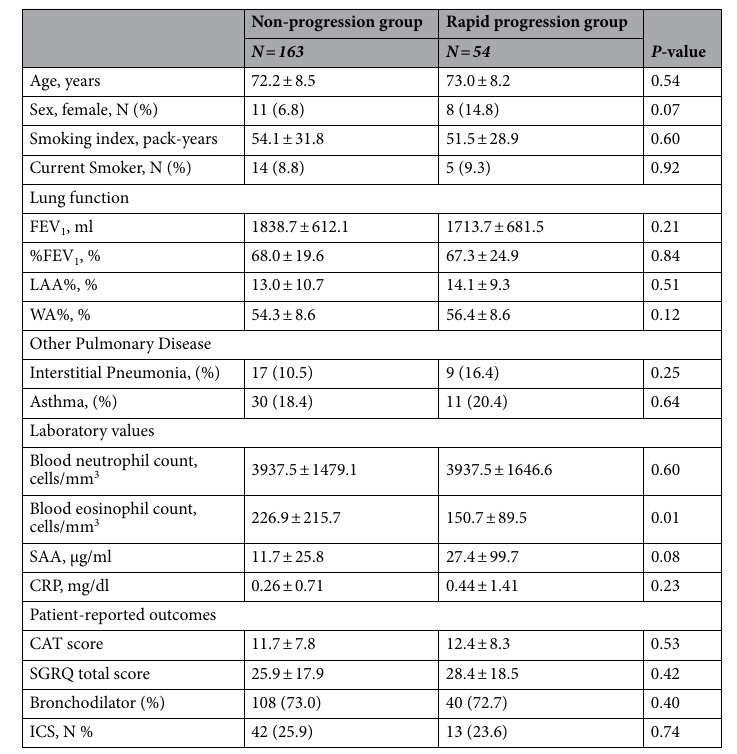
Table 2. Comparison of baseline characteristics according to group. Data are presented as mean ± SD or number (%). FEV the percentage of airway wall area, SAA serum amyloid A, CRP C-reactive protein, CAT chronic obstructive pulmonary disease assessment test, SGRQ St. George’s Respiratory Questionnaire, ICS inhaled